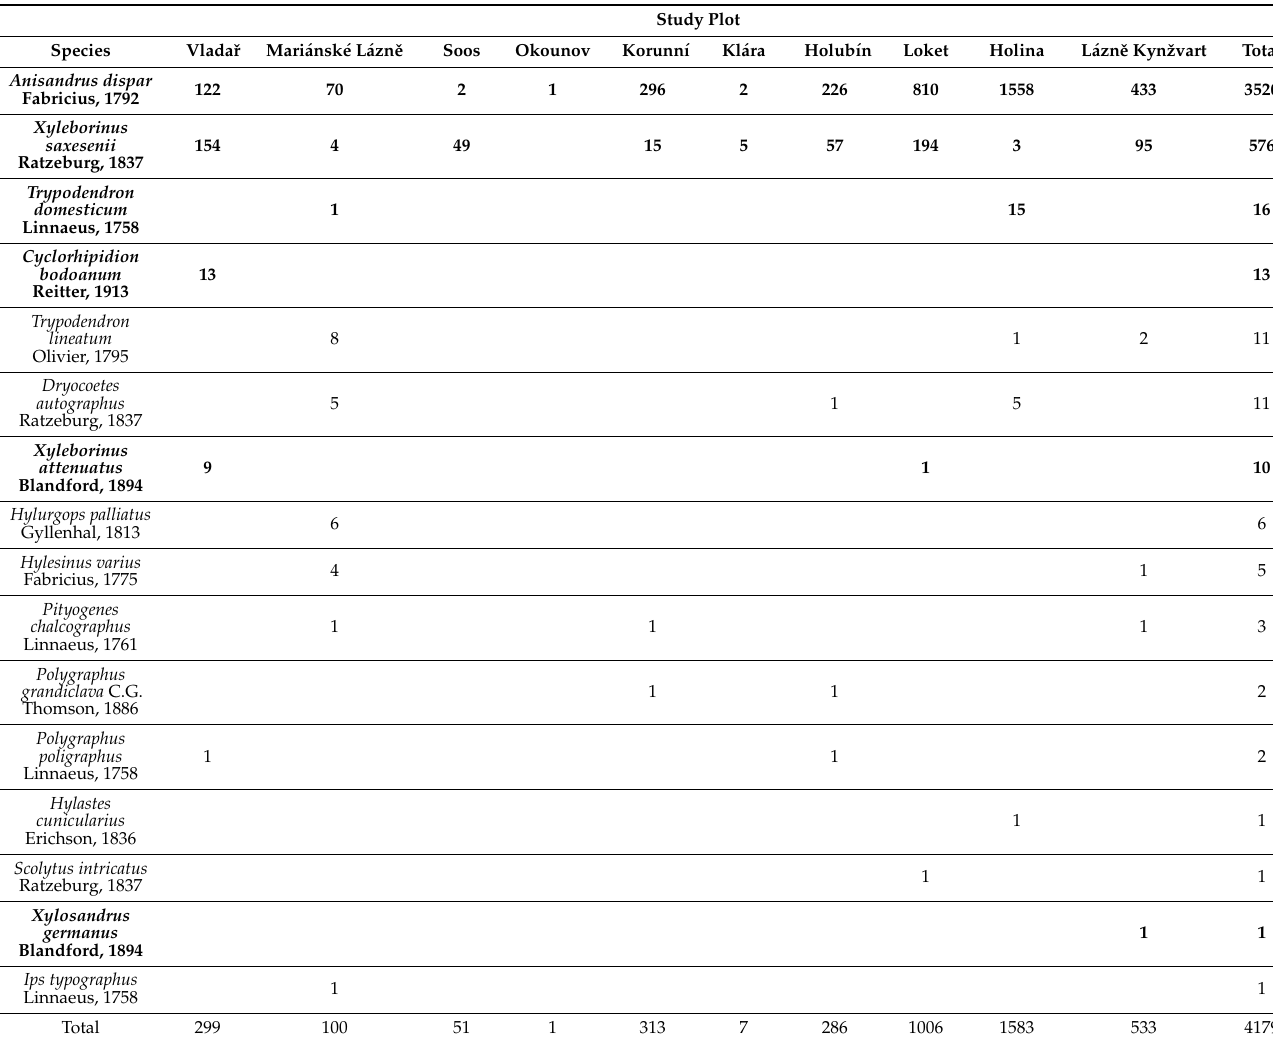
Table A1. Total numbers of bark beetles that were trapped at the 10 studied localities in the western Czech Republic (ambrosia beetle species that use oak trees as hosts are in